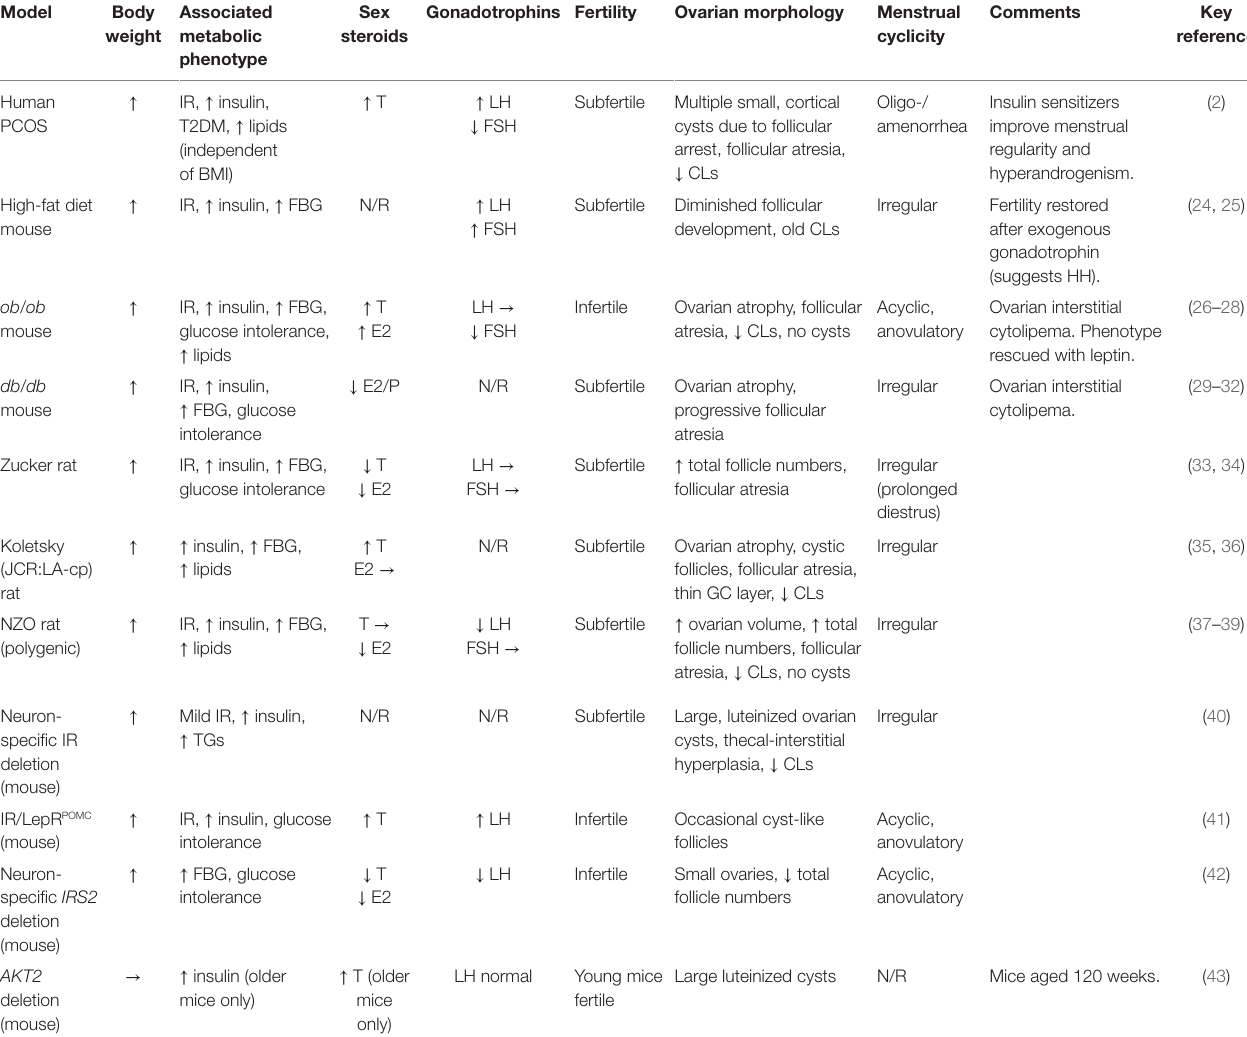
TABLe 1 | Reproductive features of rodent models of obesity and insulin